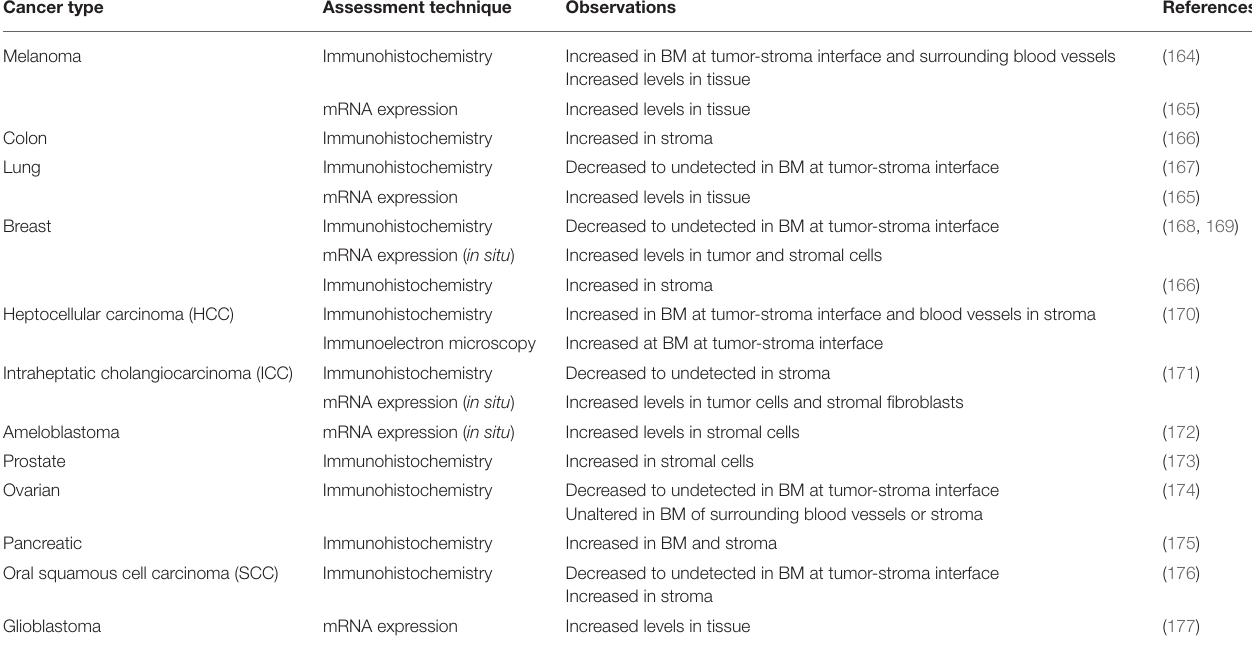
TABLE 1 | Summary of in vivo observations for perlecan expression in various cancer